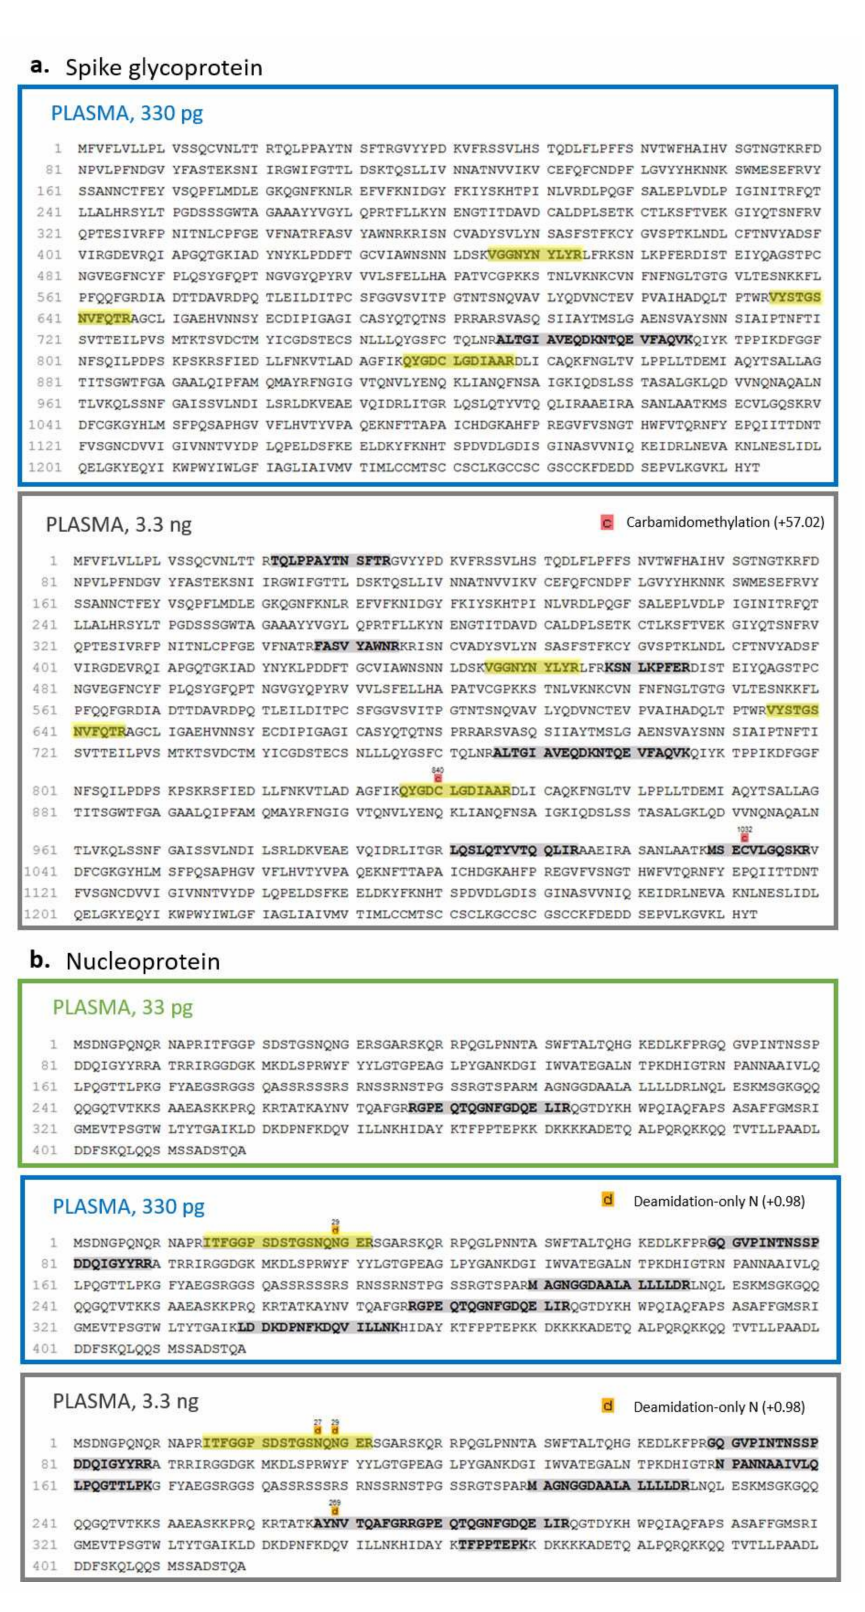
Figure 7. Sequence coverage of the spike glycoprotein and the nucleoprotein in plasma (post- digestion). Peptides identified for the spike glycoprotein ( a ) and the nucleoprotein ( b ) analysing 33 pg, 330 pg and 3.3 ng of each purified SARS-CoV-2 protein (S1, S2, RBD and N) spiked into plasma after digestion. Possible sites of N-glycosylation are identified with letter d and the number of the AA sequence. The sequence covered is in bold and highlighted in grey or yellow, peptides highlighted in yellow are those also observed in the